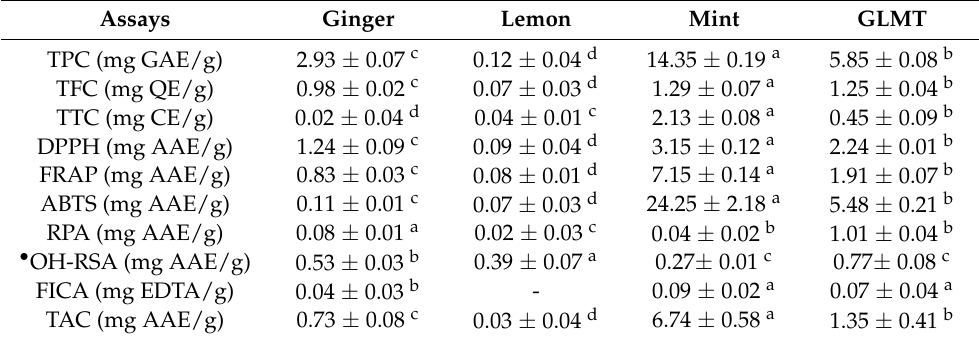
Table 1. Phenolic compound content (TPC, TFC and TTC) and antioxidant activities (DPPH,